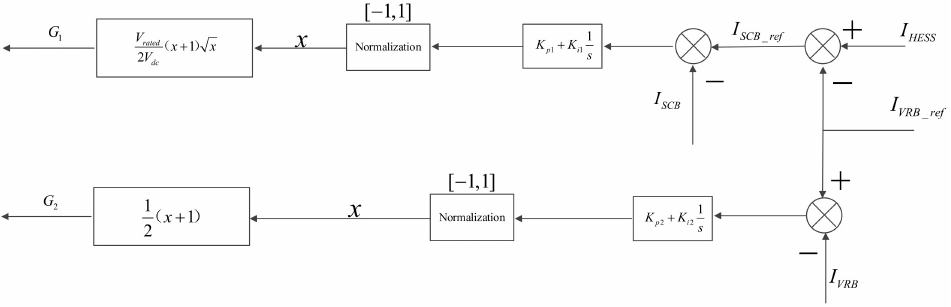
Figure 12. Control structure of SCB and